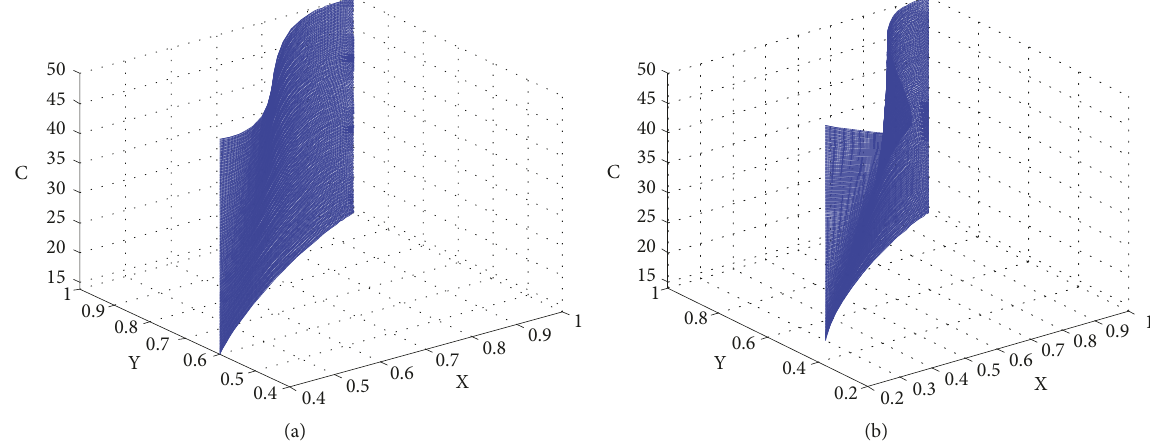
Figure 11: The change in C with respect to the initial values of (0.4,0.6) and (0.3,0.5) in Scenario